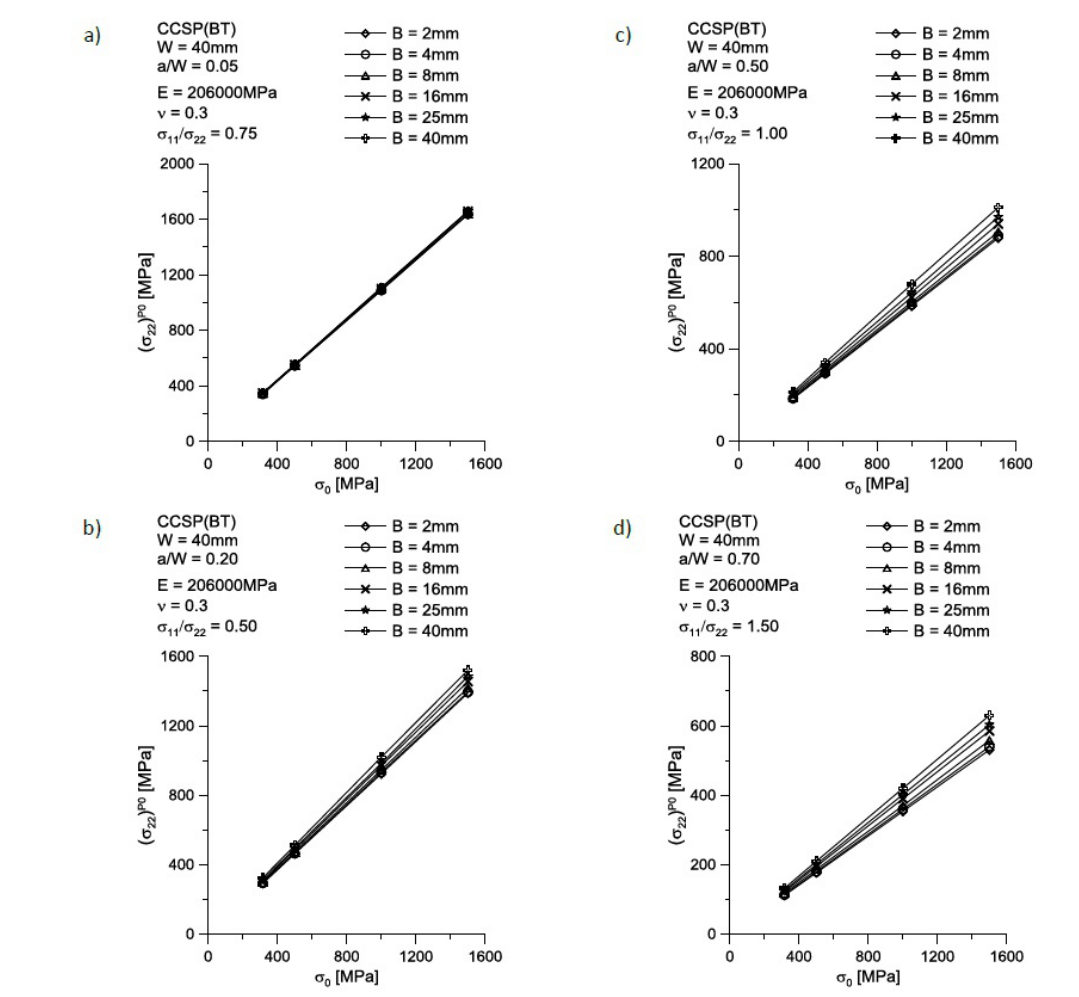
Figure 16: Limit load ( σ 22 ) P 0 against yield strength for three-dimensional cases at fixed ratio and relative crack length.